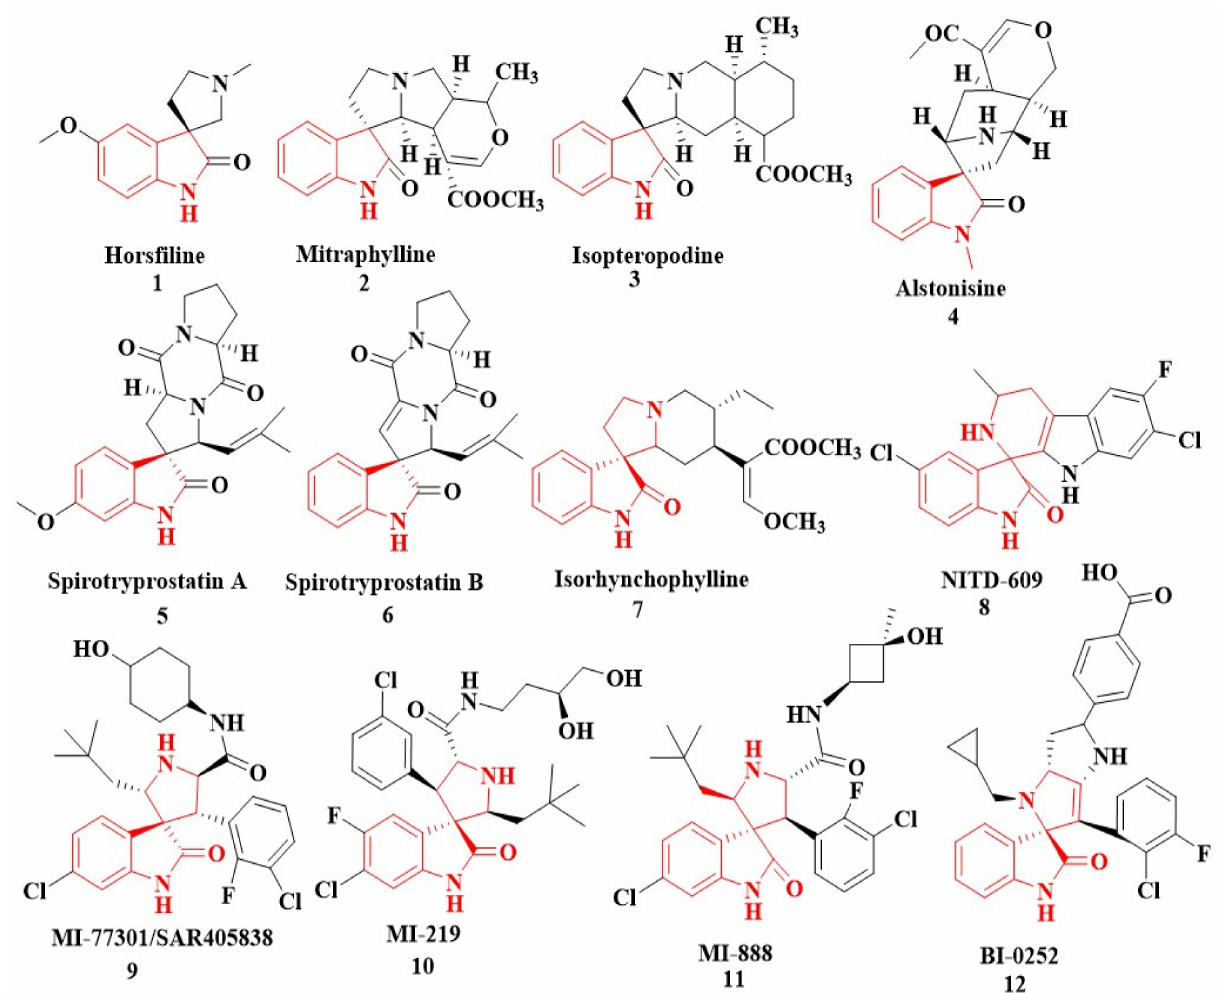
Figure 1. Representation of naturally occurring ( 1 – 6 ) and synthetic and biologically active SOXs ( 7 – 12